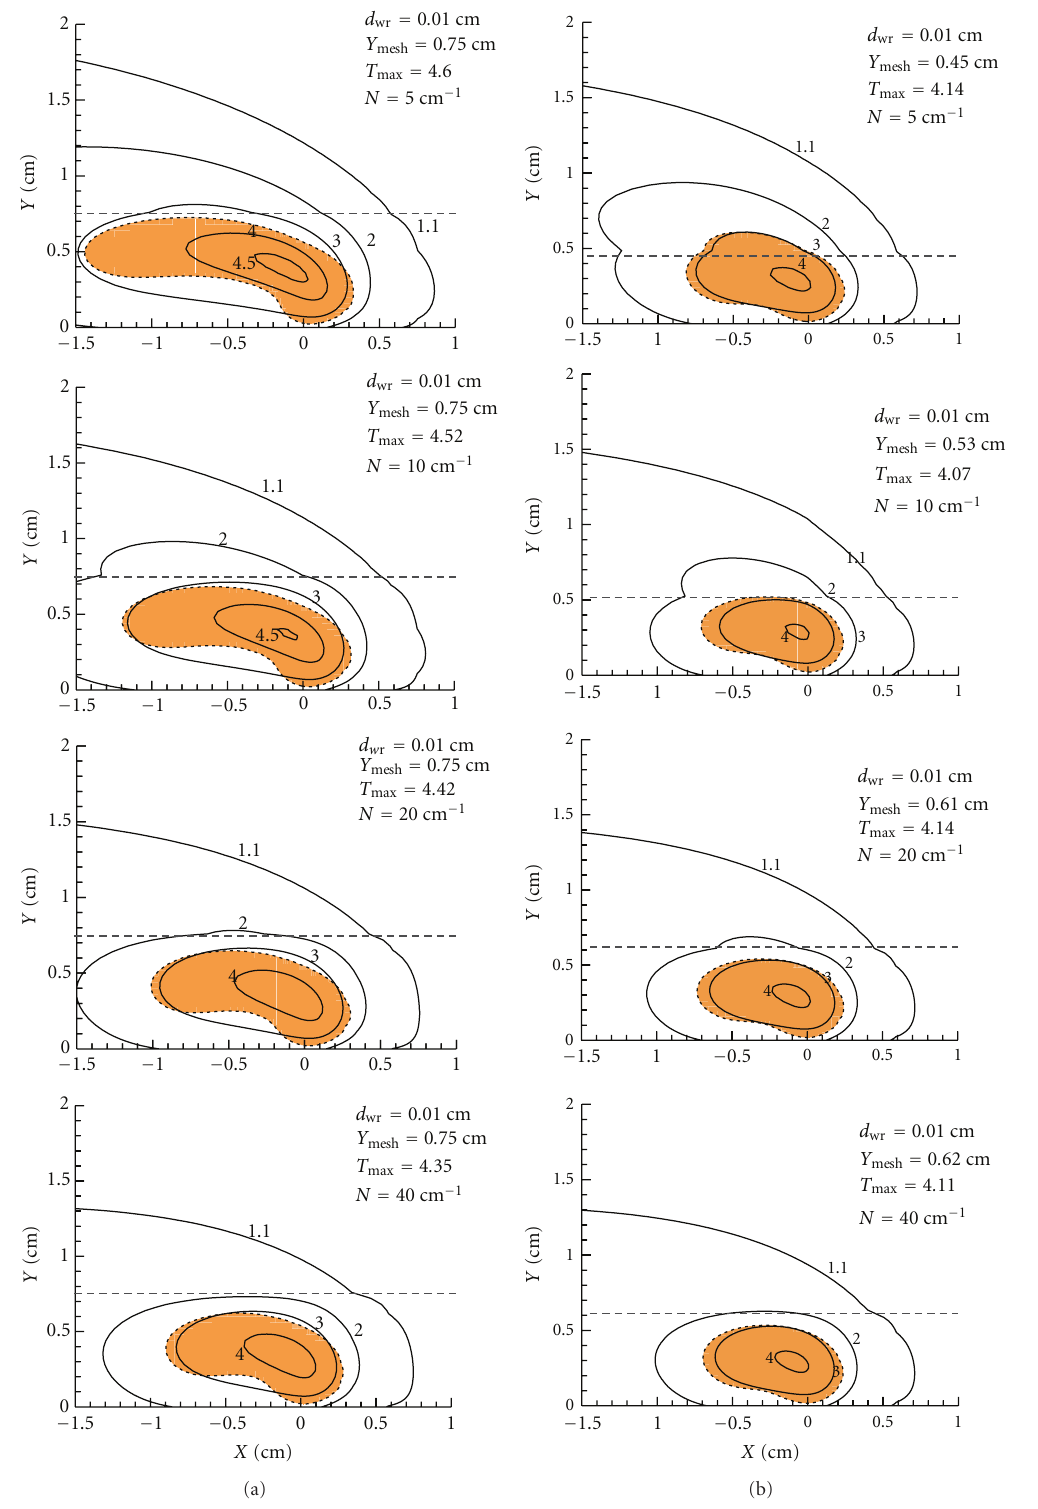
Figure 6: E ff ect of N on flame size and temperature field. (a) Y mesh = 0.75 cm and (b) Y mesh = near extinction. The dashed line represents wire